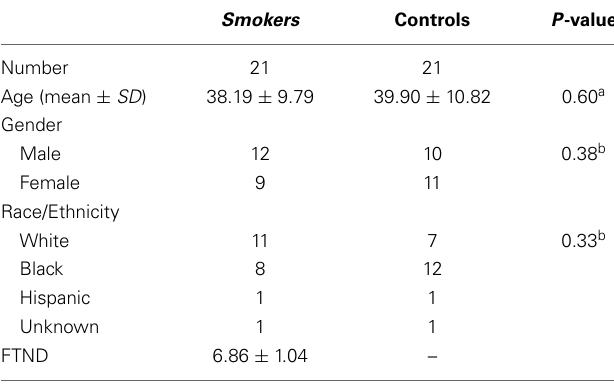
Table 1 | Demographic characteristics of study